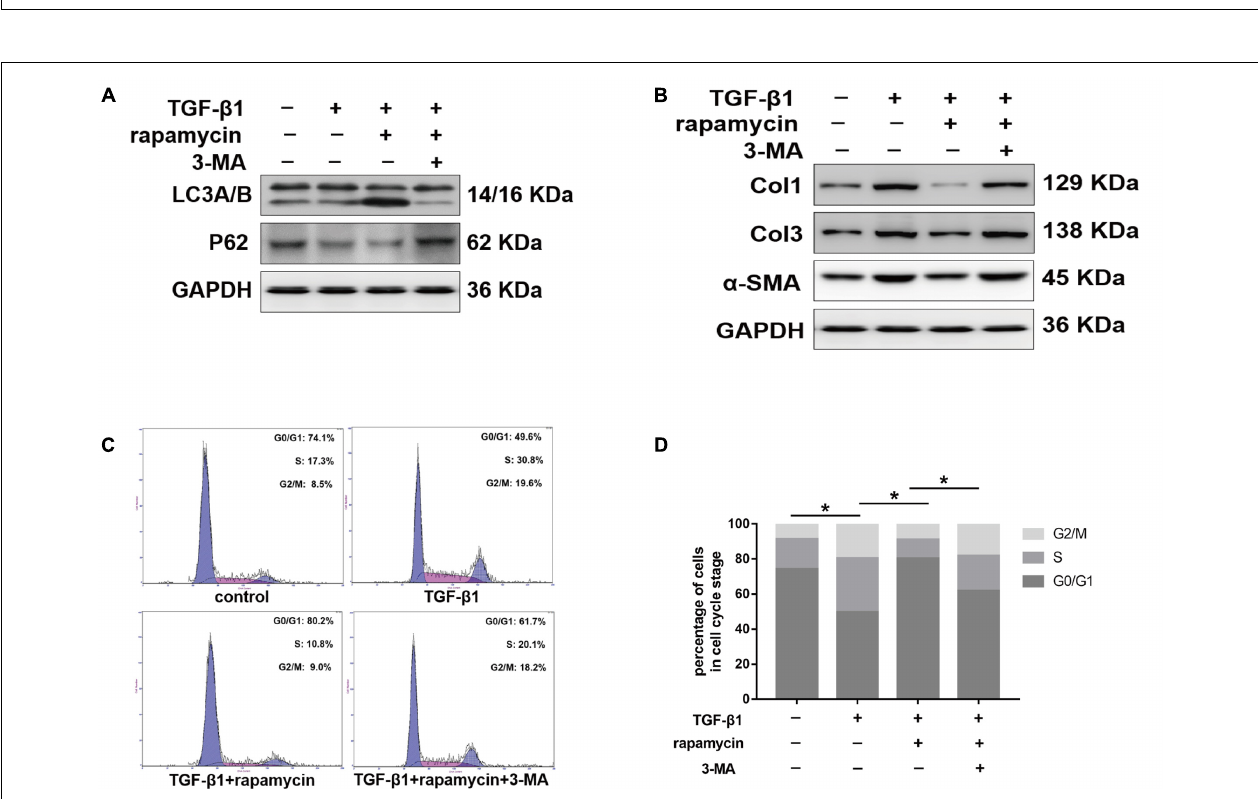
FIGURE 12 | 3-MA abolishes the protective effects of rapamycin in tenocytes. Tenocytes were pretreated with 3-MA (2 mM) for 2 h before treated with TGF- β 1 and/or rapamycin. (A) Representative images of western blot analysis of LC3A/B and p62 after different treatments. (B) Representative images of western blot analysis of fibrotic genes after different treatments. (C) Representative images of flow cytometry and (D) quantitative analysis of cell cycle distribution after different treatments. The data are shown as the means ± SD of three independent experiments. ∗ P < 0.05.